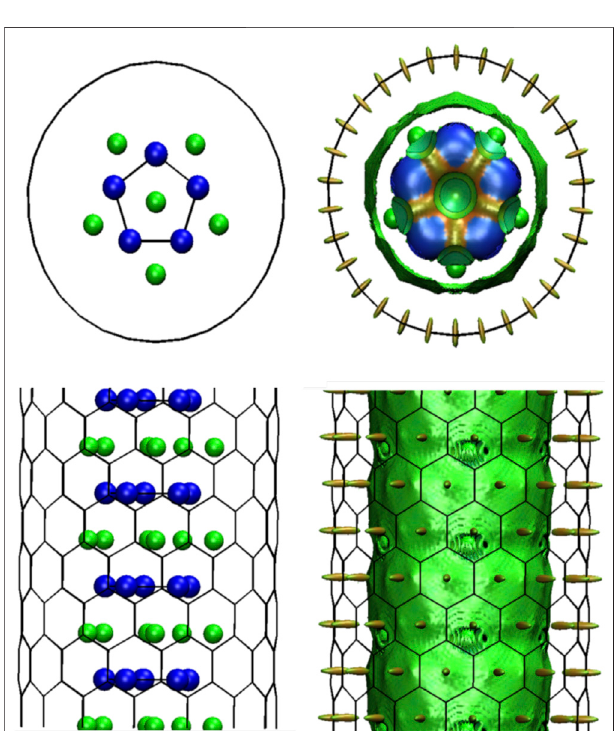
FIGURE 7 | f-Li 6 Si 5 @NTC optimized structure, for zigzag CNTs with chiral indexes (15,0), with NCI surfaces ( s (cid:2) 0.3, color range: − 0.03 to 0.03 a.u.). Geometries and electron density were taken from solid state